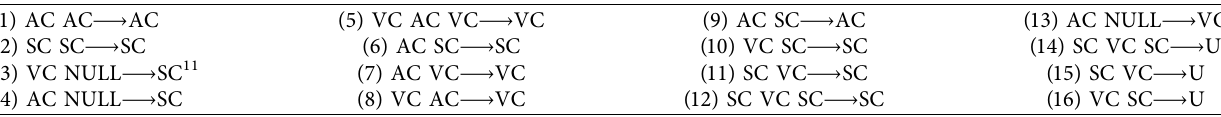
Table 9: Computational rules guided by simple categories (coordination rules in the form of A Conj A ⟶ A are also used, where A can stand for SC, AC, or VC).